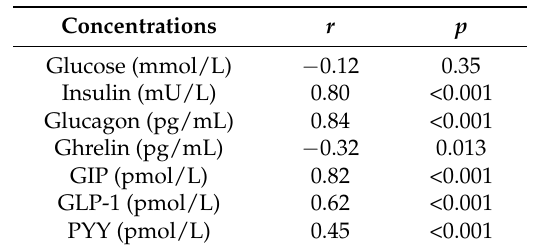
Table 2. Within-subject correlations between concentrations of total amino acids and glucose, insulin, glucagon, ghrelin, GIP, GLP-1, and PYY